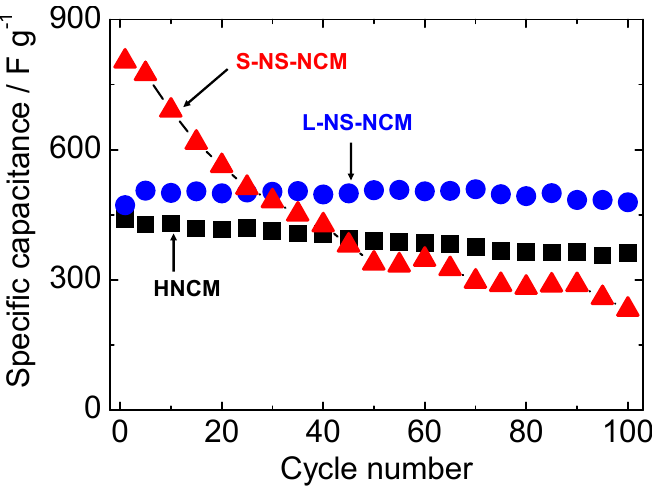
Figure 7. Cycle stabilities of HNCM, L-NS-NCM, and S-NS-NCM at a current density of